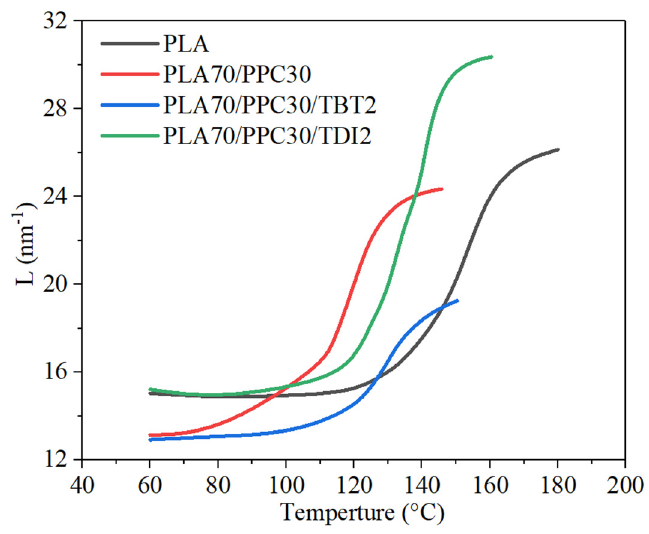
Figure 7. Long period (evaluated with Lorentz-corrected SAXS profiles) vs. cooling temperature during an in-situ DSC and SAXS cooling process at 4 °C/min of the neat PLA, PLA70/PPC30 blend, PLA70/PPC30/TBT2 blend and PLA70/PPC30/TDI2 blend.